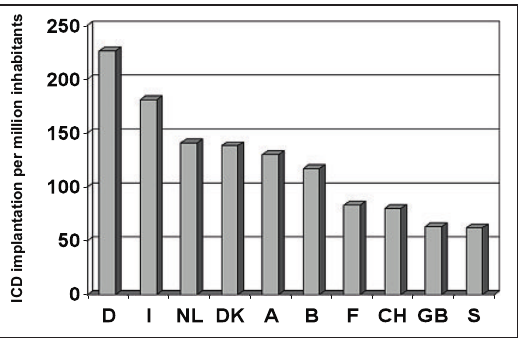
Fourfold table of dead/survival and oc- currence of ICD thera- pies showing the op- timal fold (bright dot- ted), the two interme- diate folds (dashed) and the unwanted fold (dark dotted).